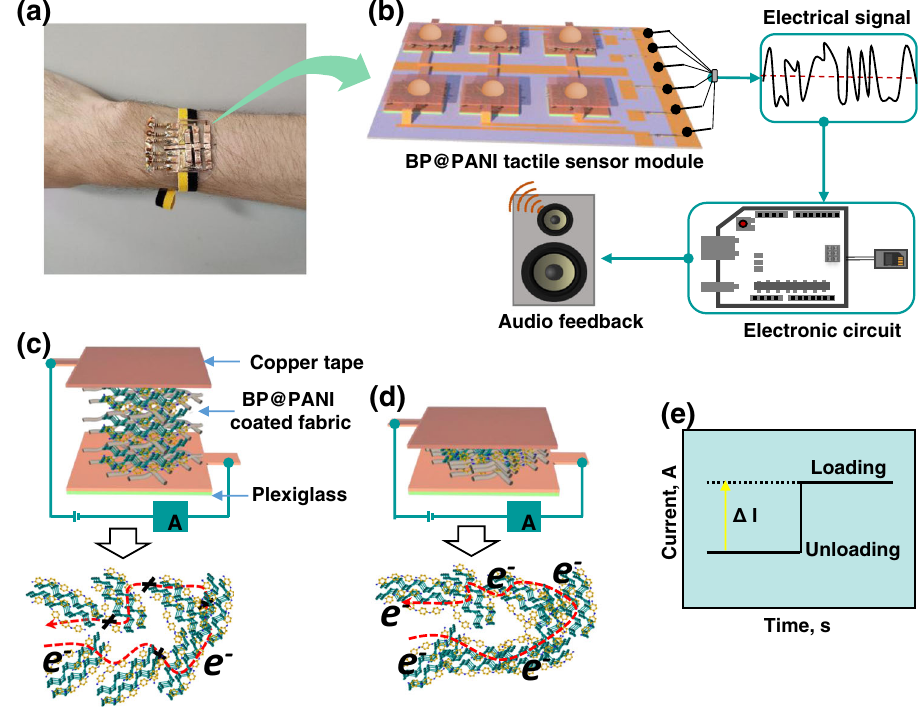
Fig. 1 | Conceptual diagram of the BP@PANI-based tactile sensor for an audi- toryhuman-machineinterface.a Wearableauditorysystemattachedonthehand of vision challenged person. b Six-pixel tactile sensor array that meets the typical